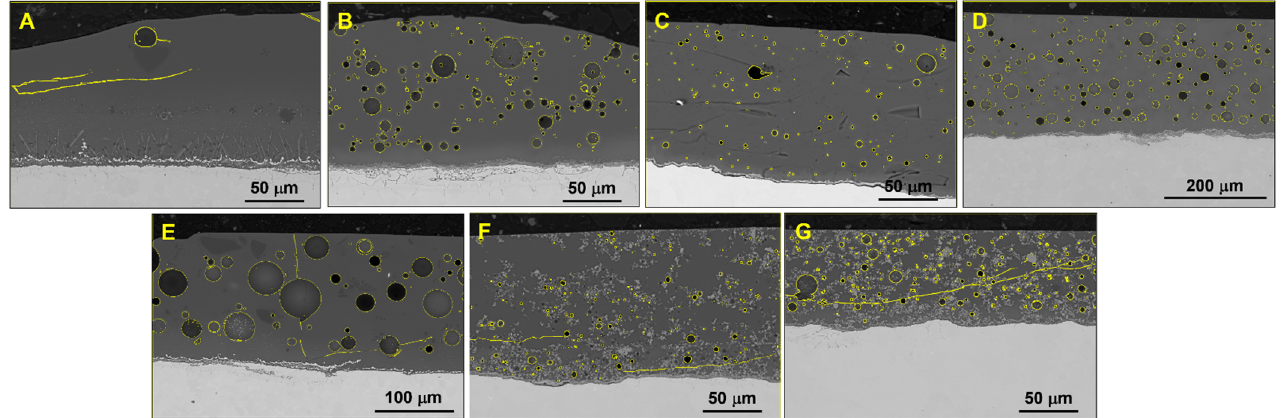
Figure 1. SEM cross-section images in the backscattered mode of the glass enamel coatings (coatings ( A – G )) in the as-fabricated condition (pores and cracks are highlighted in yellow).